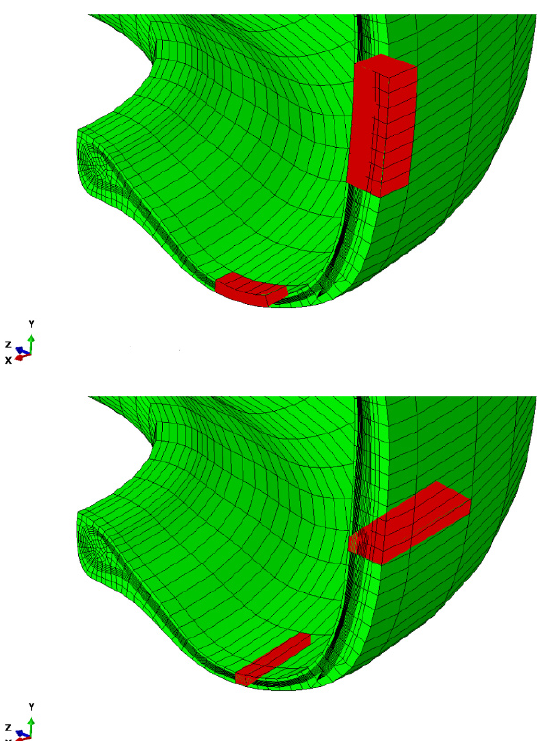
Figure 10. Radial and circumferential cutting directions. The geometric complexity of tires makes it difficult to cut specimens for classical tests. Specimens were therefore cut only in the radial and circumferential direction, but not in that of the thickness (see Figure